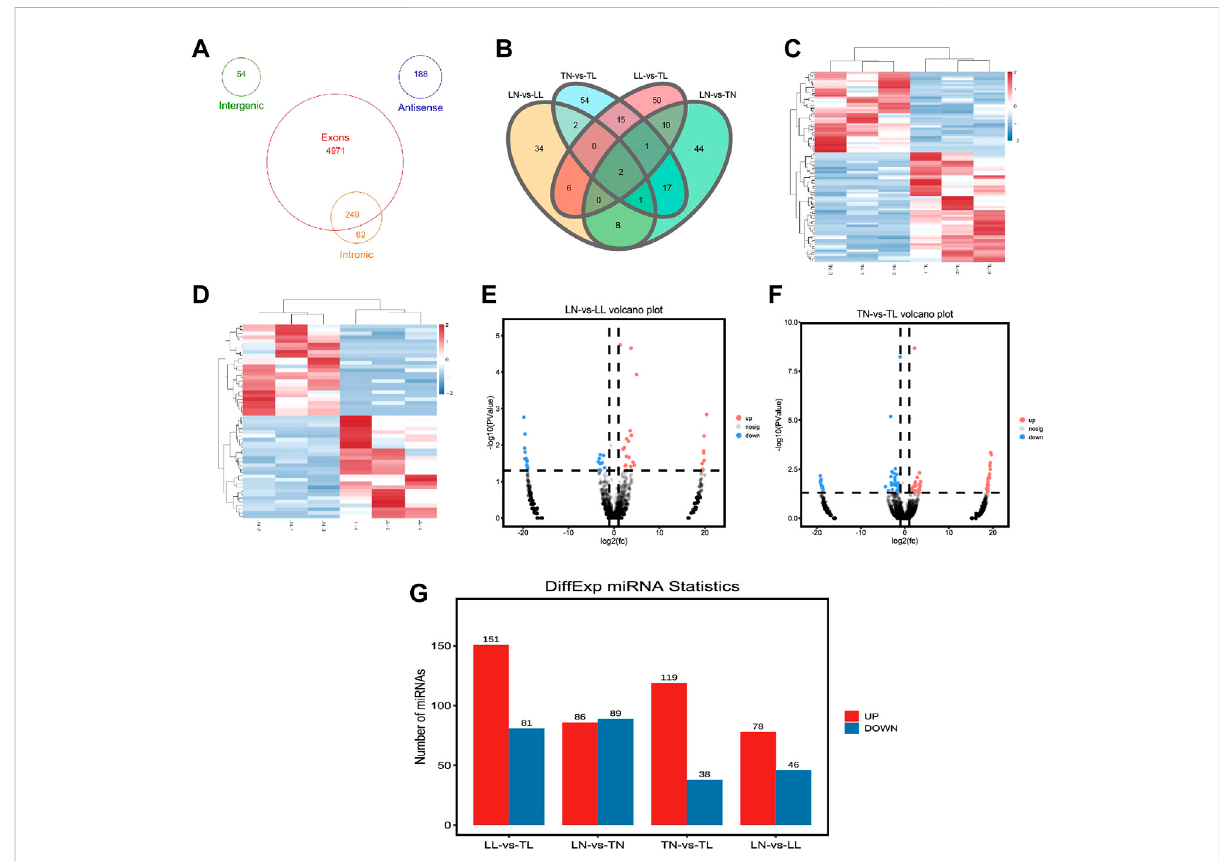
FIGURE 2 Summary of differential expression analysis of the circRNAs and miRNAs. (A) Venn diagram indicating that circRNAs numbers originated from differentgenomicsites. (B) VenndiagramofcircRNAsinteractionsbasedontheoverlappingcircRNAsamongthefourgroups. (C) Heatmapshowing the relative expression patterns of DEcircRNAs between TN and TL. (D) Heatmap showing the relative expression patterns of DEcircRNAs between LN and LL. (E) Volcano plot showing the relative expression patterns of DEcircRNAs between LN and LL. (F) Volcano plot showing the relative expression patterns of DEcircRNAs between TN and TL. (G) Histogram showing the number of DEmiRNAs identi fi ed among the four